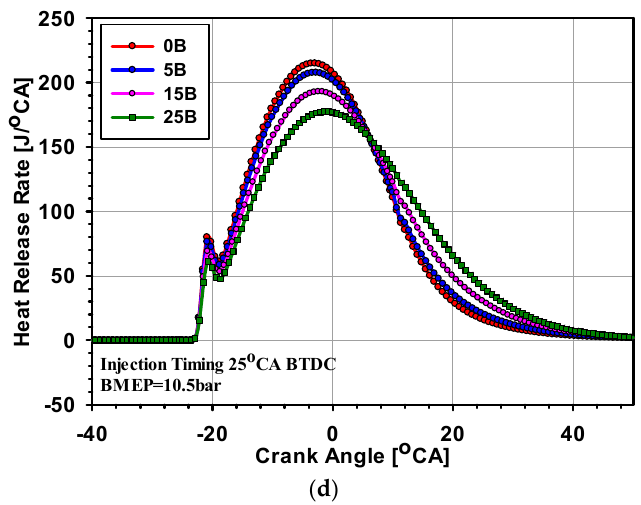
Figure 5. Variation of heat release rate: ( a ) BMEP 4.5 bar, injection timing 5 ° CA bTDC; ( b ) BMEP 4.5 bar, injection timing 25 ° CA bTDC; ( c ) BMEP 10.5 bar, injection timing 5 ° CA bTDC; and ( d ) BMEP 10.5 bar, injection timing 25 ° CA bTDC. Table 5. Maximum heat release rate.